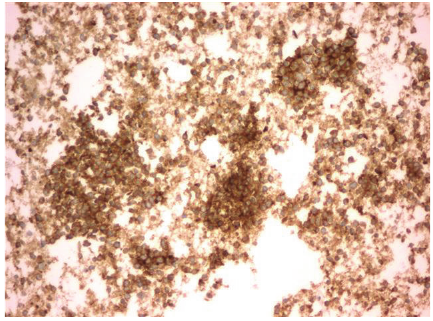
Figure 6: Cytoplasmic reactivity for CD99.